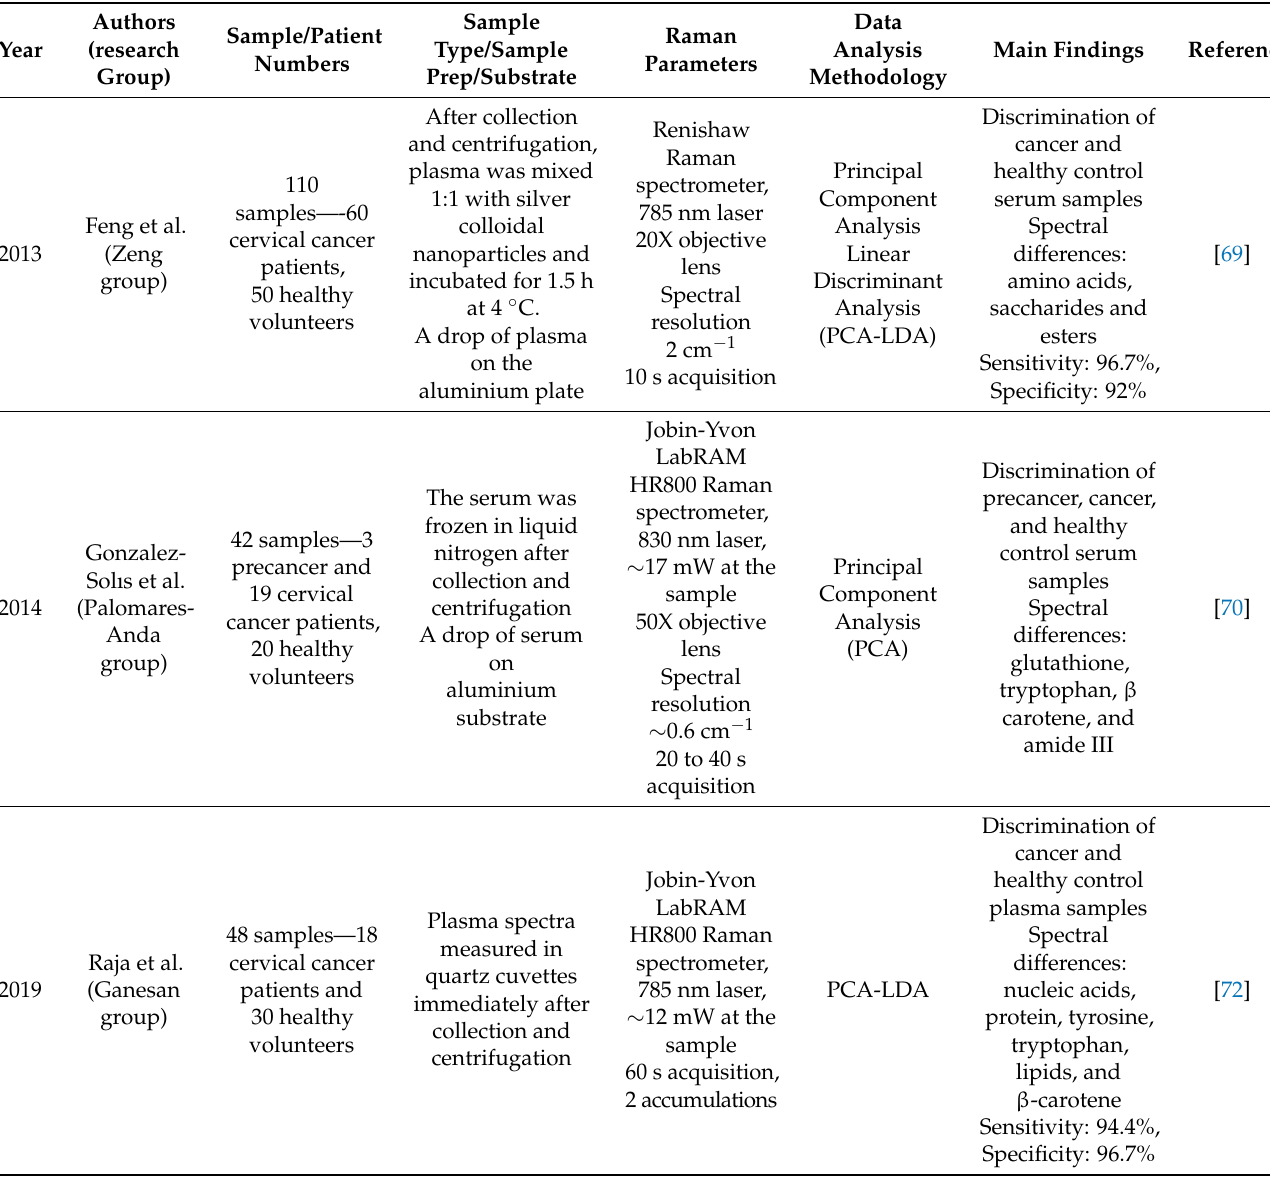
Table 4. Application of Raman spectroscopy in biofluids for cervical